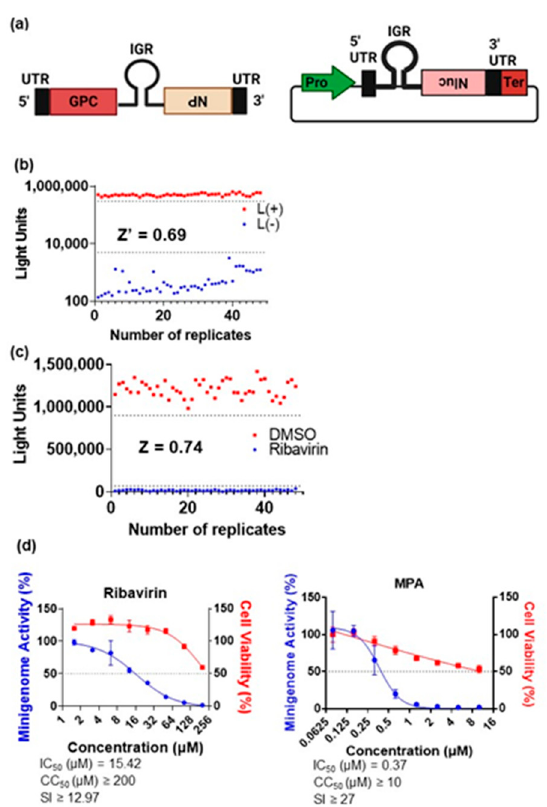
Figure 1. Construction, optimization and validation of the LASV MG. ( a ) Graphical representation of the original LASV S segment genome (left) and the LASV MG expressing the Nluc reporter, which